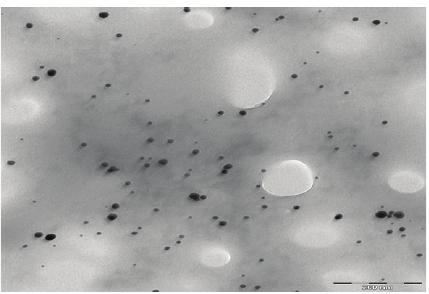
Figure 4: TEM image of AuNPs reduced with 300 mM of MSG.